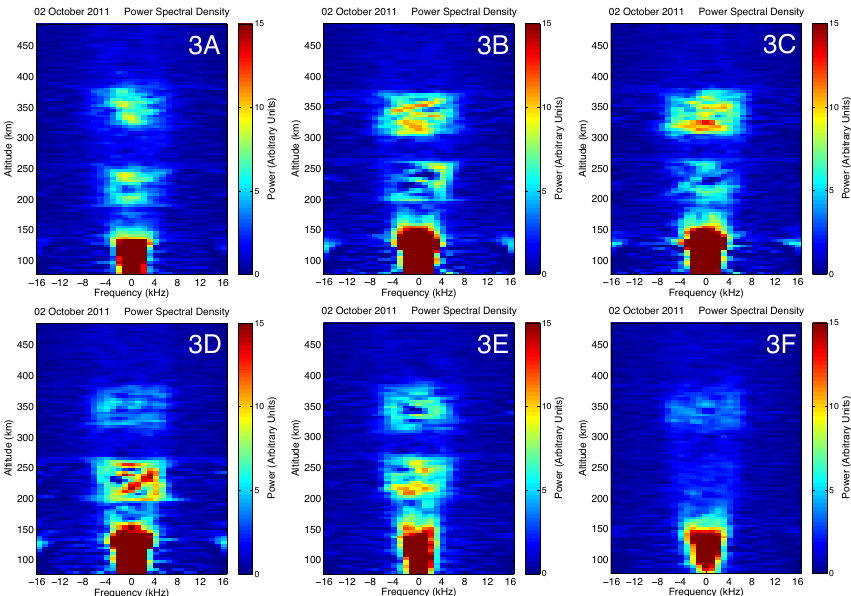
Figure 9. Event 3: NEIAL spectra from the times labeled 3A–3F in Fig. 8. There are no distinct spectral asymmetries and primarily enhanced power in the whole spectral range between the up- and downshifted ion-acoustic lines for both the higher- and lower-altitude ranges. The apparent saturation in the E region is caused by the strongly enhanced electron density due to the intense auroral precipitation present.